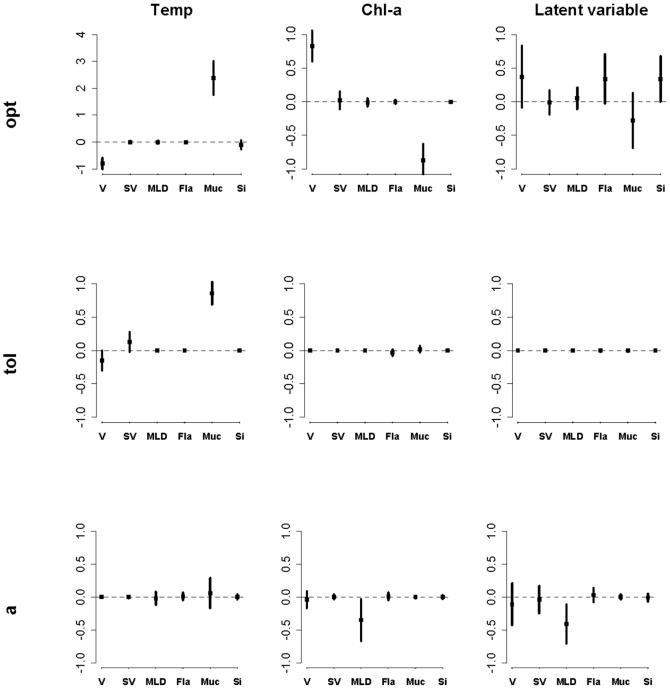
Coefficient estimate  standard deviation for traits, when Gaussian response parameters (opt, tol, a) are regressed on traits for temperature, chlorophyll-a and the linear combination of environmental variables.